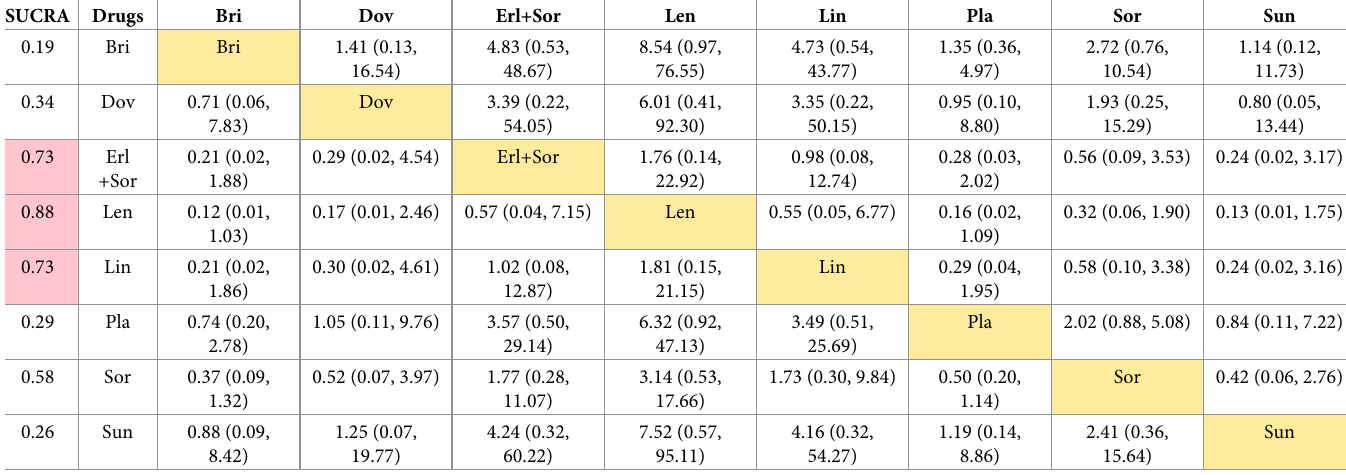
Table 5. Network meta-analyses for ORR (Findings are expressed as OR (95% CrI), use of random-effect model).